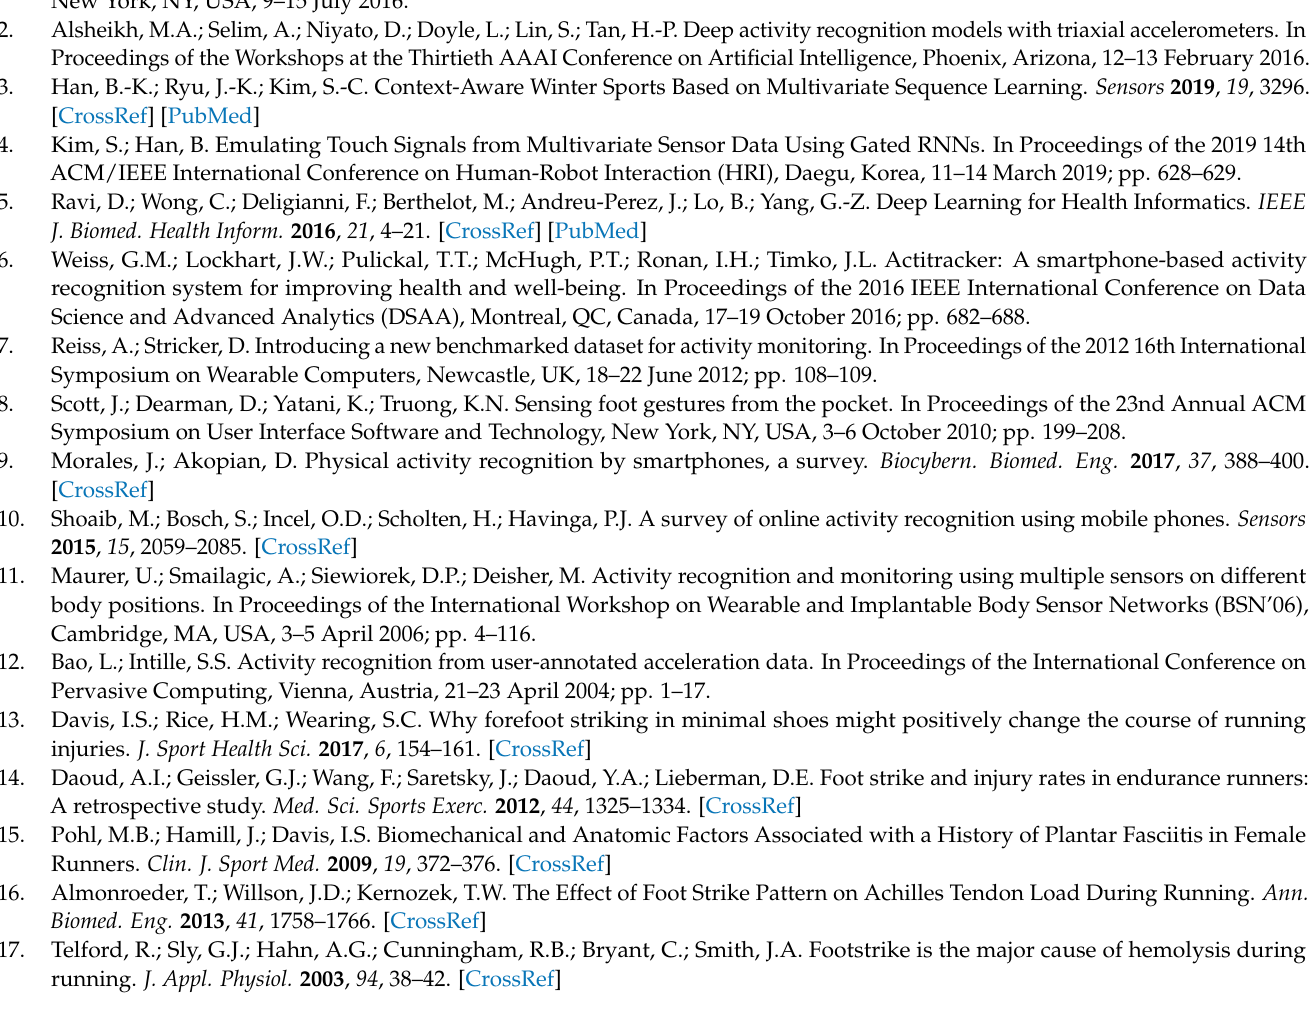
Figure A3. Visualization of internal features for recognizing the users when a GRU-based classifier is applied using t-SNE. Each color represents a different participant.